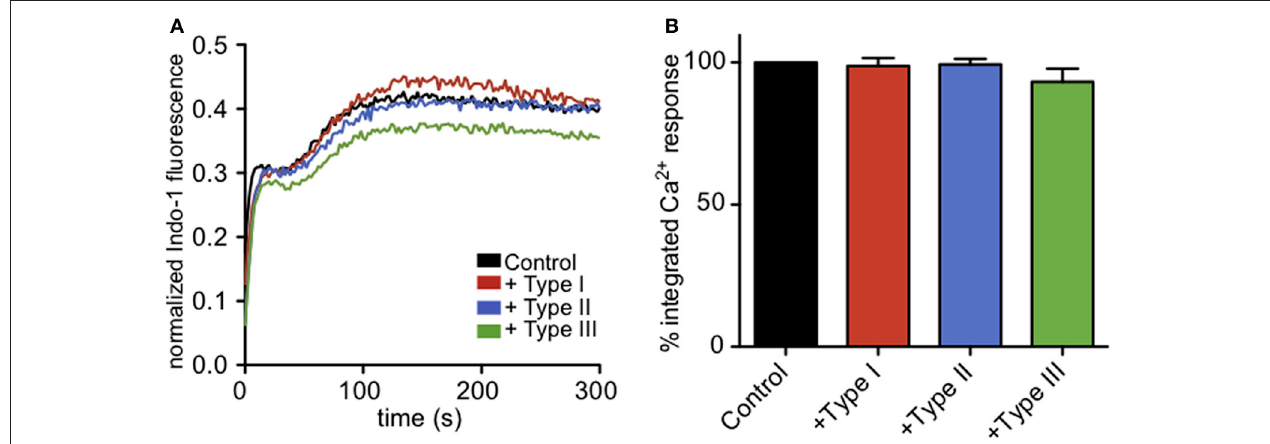
FIGURE 4 | InfectiondoesnotaffectCa 2 + responsesto ERstore releaseby thapsigargin. (A) Representativeindo-1 fluorescencemeasurementsof Ca 2 + responses to 200nM thapsigargin in control (black), Type I (red), Type II (blue),